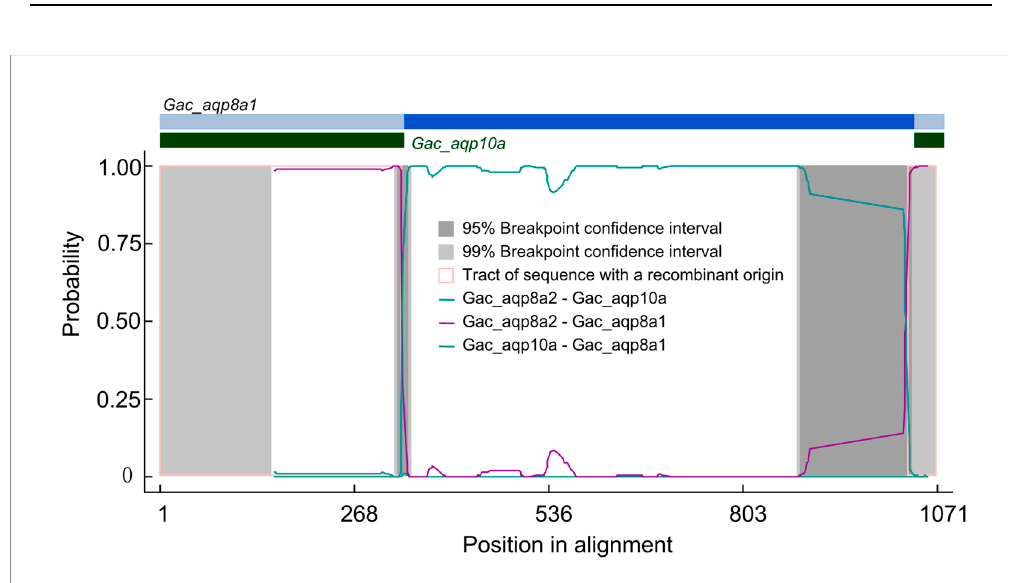
Figure 3. Identification of recombination events between Gac_aqp8a1 and Gac_aqp10a genes. The plot display of recombination events was detected by the RDP method.